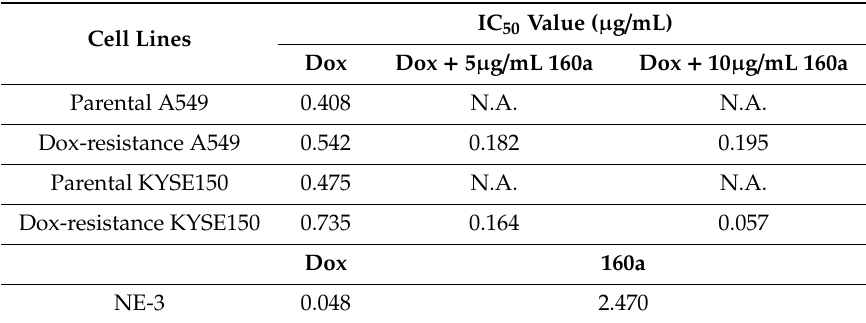
Figure 2. Cytotoxic effect of different concentrations of doxorubicin on parental and doxorubicin-resistant cancer cells co-cultured with compound 160a. ( a ) The relative MTS value of doxorubicin in the parental and dox-resistant A549 cell lines; ( b ) the relative MTS value of doxorubicin combined with compound 160a (5 μ g/mL, 10 μ g/mL) in the dox-resistant A549 cell lines; ( c ) the relative MTS value of doxorubicin in the parental and dox-resistant KYSE150 cell lines; ( d ) the relative MTS value of doxorubicin combined with compound 160a (5 μ g/mL, 10 μ g/mL) in dox-resistant KYSE150 cells; ( e ) the relative MTS value of compound 160a in NE-3 non-cancer cells; ( f ) the relative MTS value of doxorubicin in NE-3 non-cancer cells. Dissolved in dimethyl sulfoxide (DMSO) (0.1%) was applied as a vehicle control ( n = 4). ^ p < 0.05, ^^ p < 0.01 comparing the 5 μ g/mL compound 160a group with the control group; * p < 0.05, ** p < 0.01 comparing the 10 μ g/mL compound 160a group with the control group. Table 2. IC 50 values ( μ g/mL) of doxorubicin (Dox), Dox combined with compound 160a on parental cancer cell lines or Dox-resistance cancer cell lines, and Dox or compound 160a alone on non-tumor cell line (NE-3).